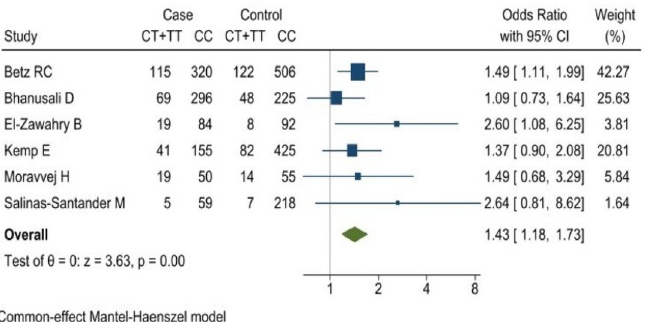
Fig 4. Association between rs2476601 polymorphism of PTPN22 gene and risk of alopecia areata. Dominant model ( CT + TT vs CC ).